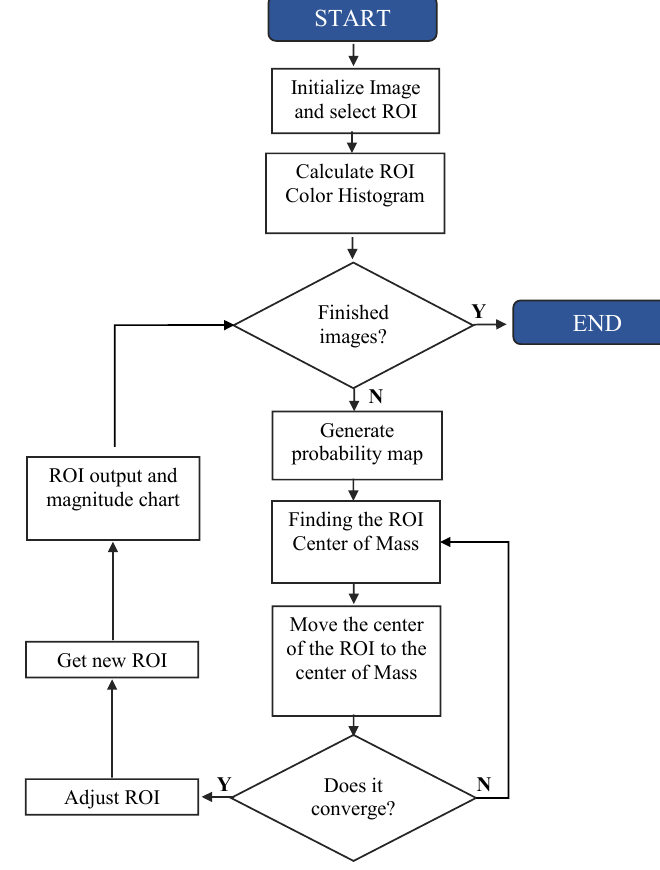
Figure 6. Flowchart of the CAMSHIFT